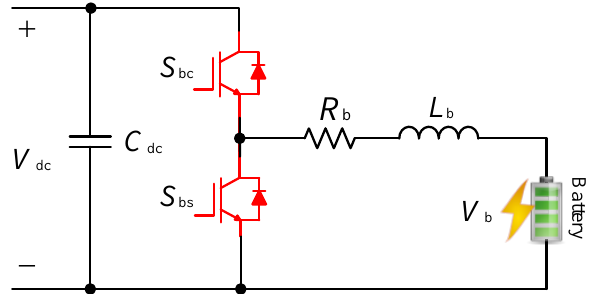
Figure 7. Bidirectional Buck converter as the EV-interfaced converter.